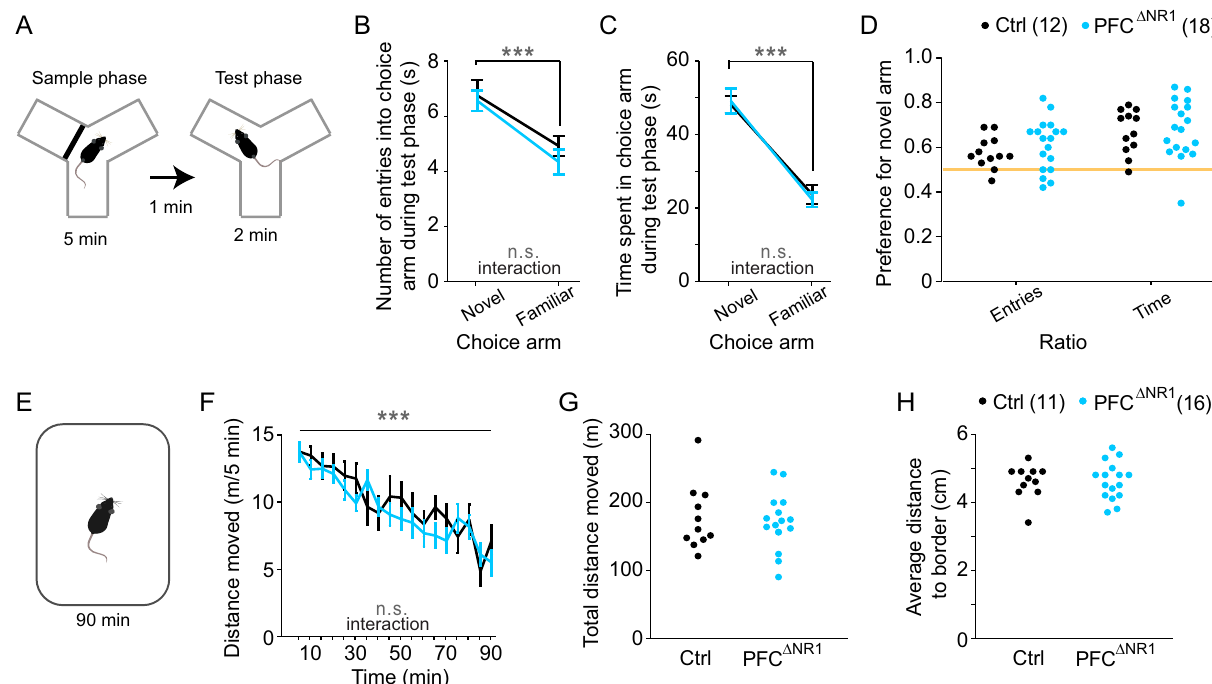
Figure 5. Assessment of spatial short-term habituation. ( A ) Illustration of the spatial novelty-preference test which consists of a 5 min sample phase, a 1 min ITI, and a 2 min test phase. ( B, C ) Number of entries (B) and time spent (C) in the novel and familiar choice arms during the test phase. Grey indicators, effect of arm and group-arm interaction in overall RM-ANOVA. ( D ) Preference ratios for the novel arm calculated based on the data in (B) and (C). ( E ) Illustration of novelty-induced hyperlocomotion test. ( F ) Locomotor activity measured in moved distance in 5 min intervals over the 90 min of the test. Grey indicators, effect of time bin and group- time interaction in overall RM-ANOVA. ( G ) Total locomotor activity over 90 min of individual mice (dots, colour-coded as in (F)). ( H ) Same display as in (G) but for the average distance to the border of the open field over 90 min as a proxy for anxiety. No effects of group were found (RM-ANOVA, B, C, F; t -test, D, G, H). The legend indicates the colour-code and size of each group. See also Supplementary Table 4 for all related statistics. n.s., P > 0.1, *** P < 0.001. Error bars,